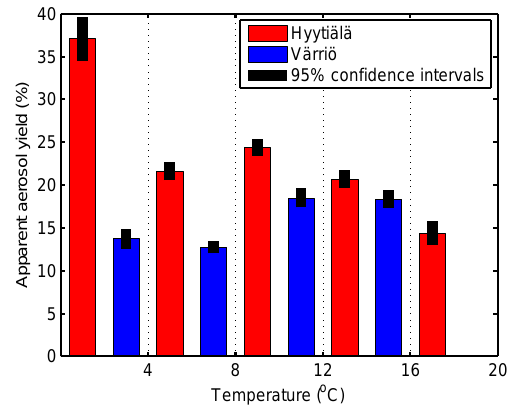
Figure 9. Estimated aerosol yield (i.e. the direct fitting slope be- tween aerosol mass and total monoterpene emission) in five tem- perature bins both at the SMEAR I station (blue bars) and the SMEAR II station (red bars). The black bars indicate 95% confi- dence intervals from the fitting slopes at both